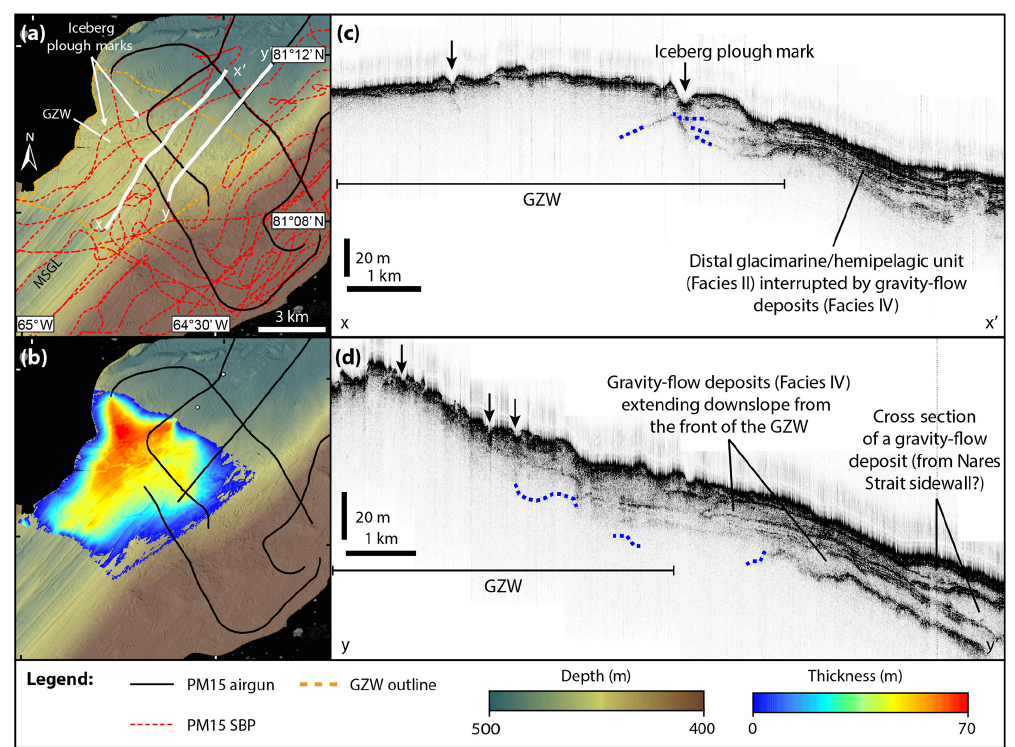
Figure 10. Mapping of the Kennedy Channel GZW. (a) AG and SBP profiles over the GZW and outline used for volume calculations. (b) Isopach map for the Kennedy Channel GZW (using a sound velocity of 1500ms − 1 ). (c) SBP profile over the GZW showing the acoustically semi-transparent lenticular bodies (Facies IV) interfingered with acoustically stratified conformable units downslope (Facies III); location shown in panel (a) . (d) SBP profile of the frontal part of the GZW showing semi-transparent units tapering downslope (Facies IV); location shown in panel (a) . Black arrows point to iceberg plough marks; blue dashed lines show the deepest sub-bottom reflections in the GZW interpreted as the base of the